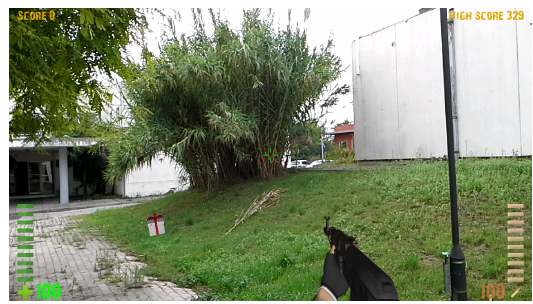
Figure 8: ARZombie game interface.